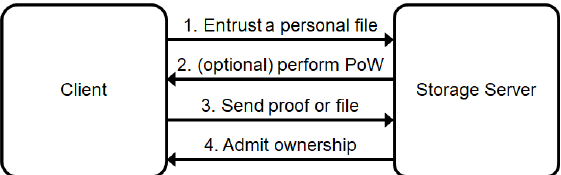
Figure 1. Client-side